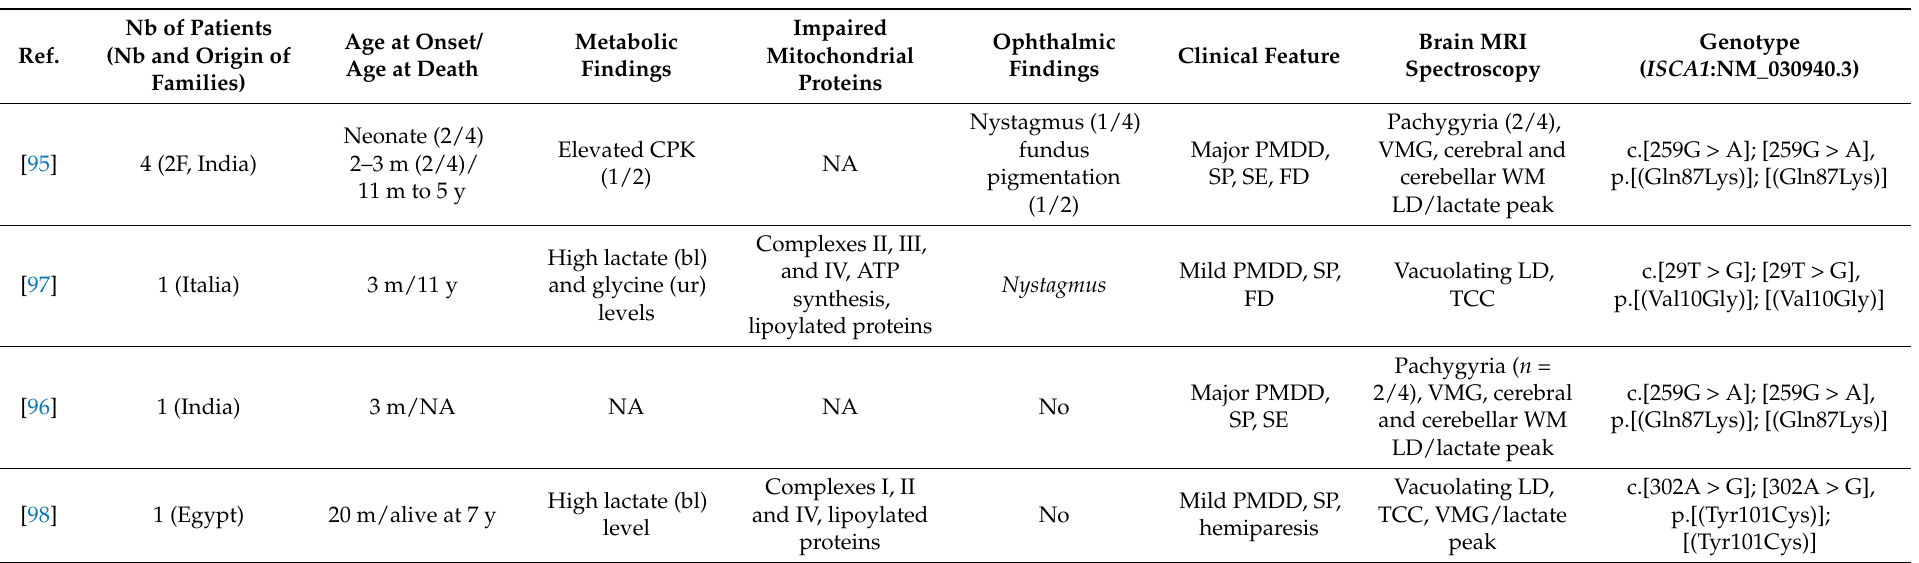
Table 5. Reported patients with MMDS type